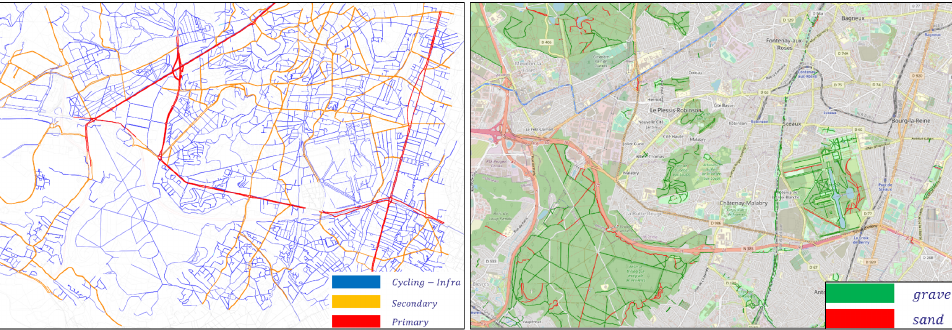
Figure 6. Type and pavement surface of bicycle infrastructure in the study area. The simulation uses a synthetic population of 9566 cyclists (8% of the whole population of 126,151 agents). ( Left ): primary highways (red) and secondary highways (orange) are prohibited (or to avoid) for cyclists, and the remaining routes are mainly residential (blue) cyclist friendly. ( Right ): gravel and sand routes are concentrated in the green spaces, and the remaining routes are considered